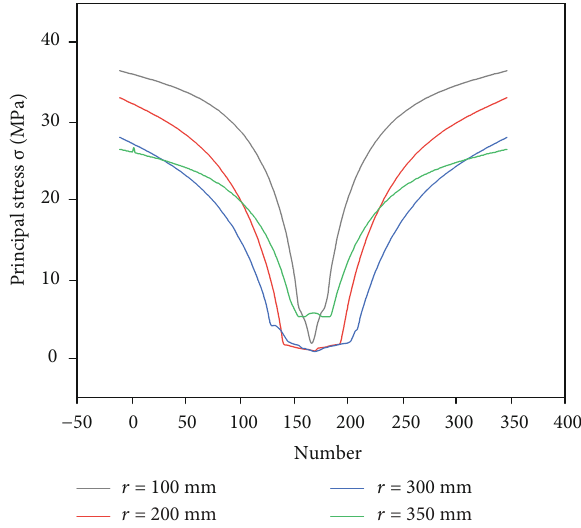
Figure 14: Distribution curves of principal stresses for 4